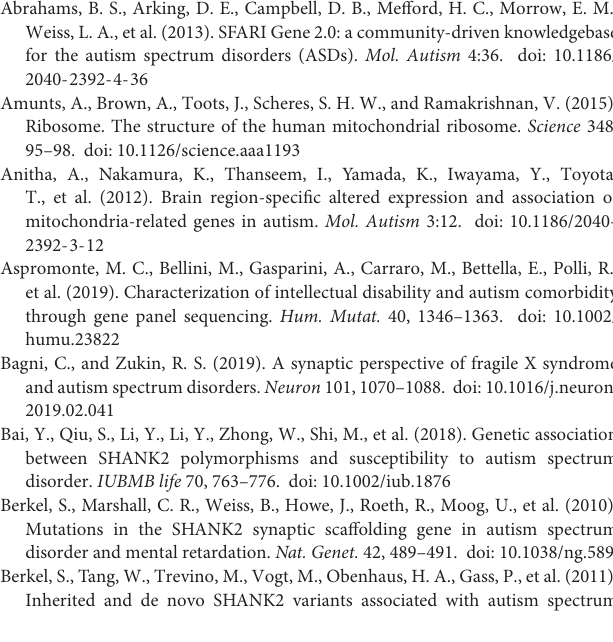
Supplementary Figure 6 | GSEA of transcriptomes from W12-HT Shank2 -mutant mice for biological functions in the C5-BP (biological process) domain. (A,B) GSEA results for W12-HT transcripts showing the list of top five positively (red) and negatively (blue) enriched gene sets (A) and their integrated visualization generated using Cytoscape EnrichmentMap App (B) ( n = 4 mice for WT, HT, and HM, FDR < 0.05). Supplementary Figure 7 | GSEA of transcriptomes from W12-HT Shank2 -mutant mice for biological functions in the C5-MF (molecular function) domain. (A,B) GSEA results for W12-HT transcripts showing the list of top five positively (red) and negatively (blue) enriched gene sets (A) and their integrated visualization generated using Cytoscape EnrichmentMap App (B) ( n = 4 mice for WT, HT, and HM, FDR < 0.05).